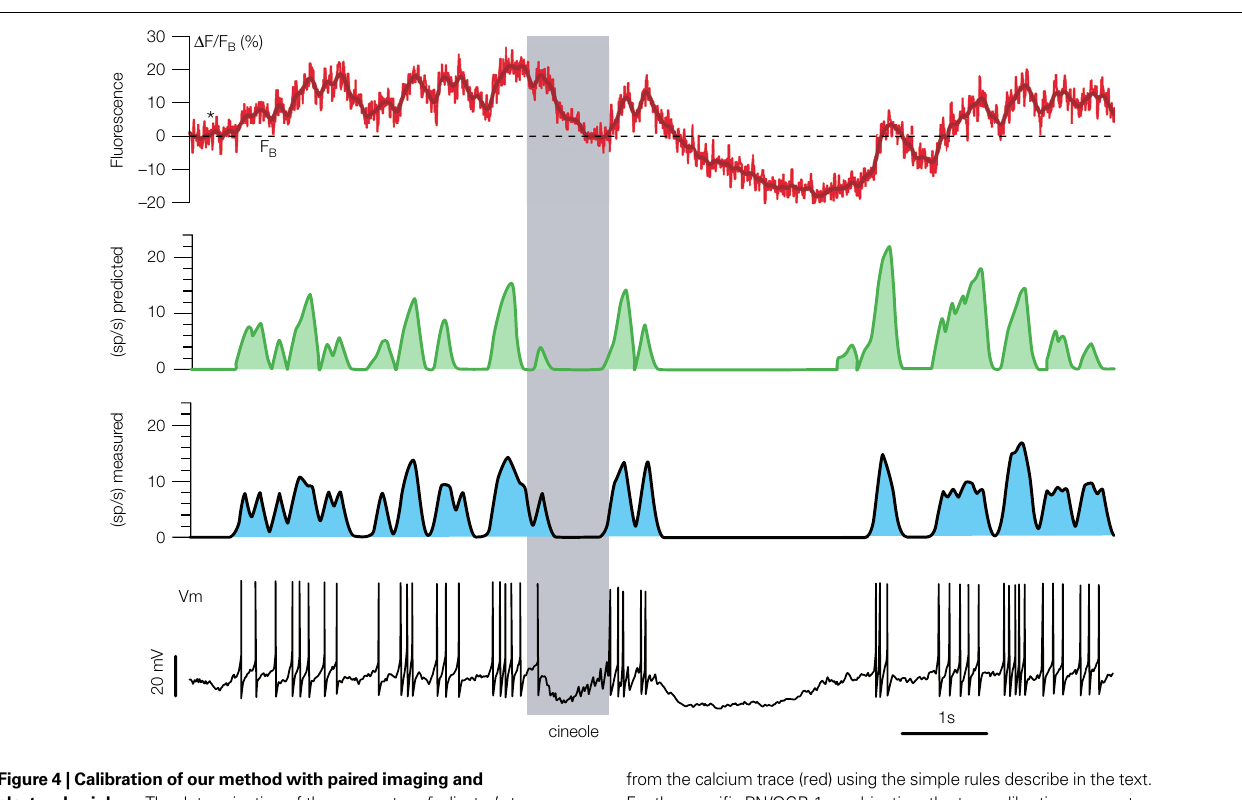
from the calcium trace (red) using the simple rules describe in the text. For the specifi c PN/OGB-1 combination, the two calibration parameters were extracted from only fi ve 16 s-long single trials with 1 s odor presentations on different PNs. Stippled line (fl uorescence trace) indicates F experiment-specifi c